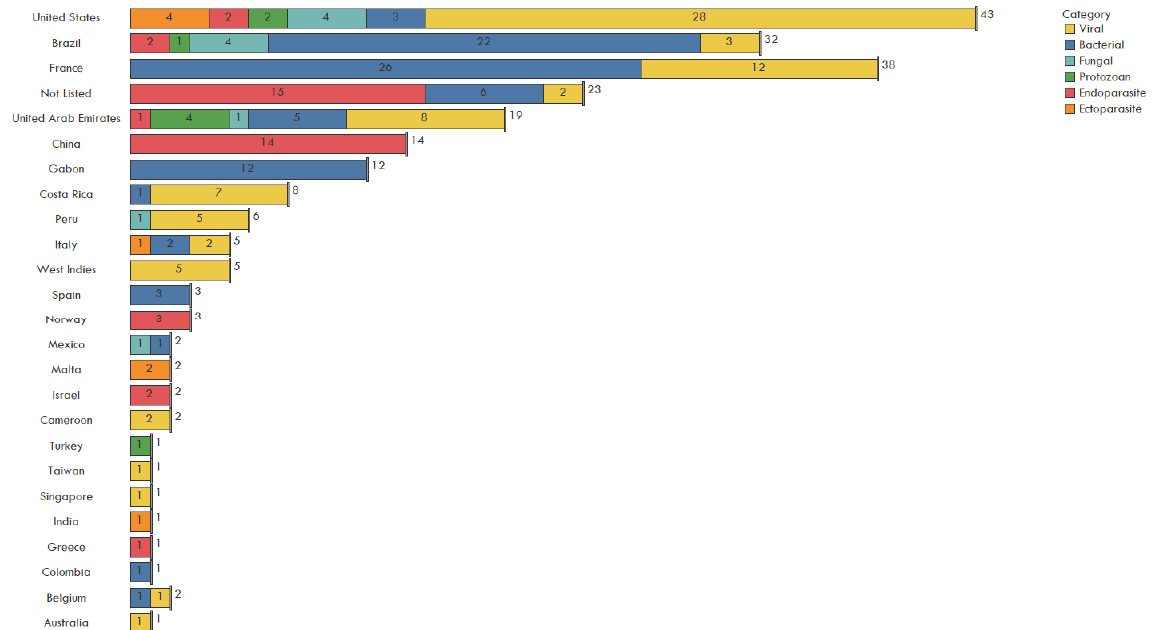
Figure 5. Number of species by taxa including mammals, birds, reptiles, amphibians, and fish from unique illegal wildlife trade events by country of import, 1990–2020.